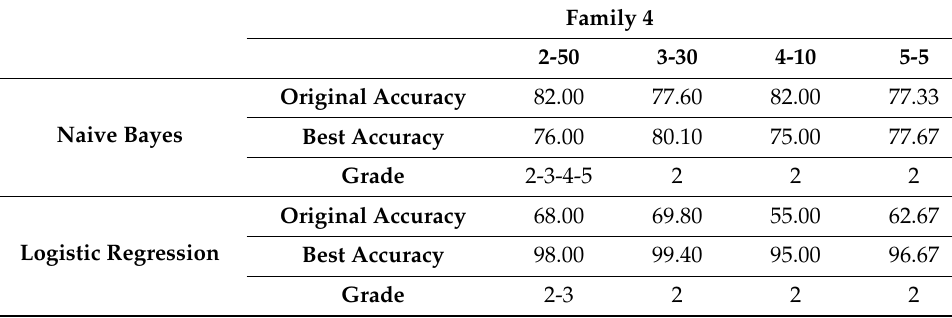
Table A4. Table corresponding to results of artificial data from Family